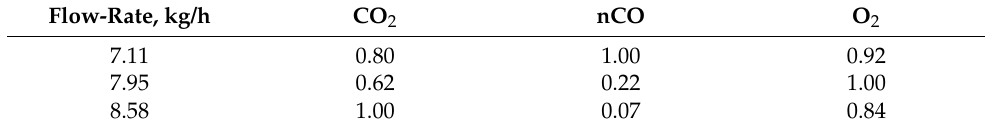
Table 2. Relative pollutant emission concetration (cid:101) C i depending on the diesel mass flow rate. Flow-Rate, kg/h CO 2 nCO O 2 7.11